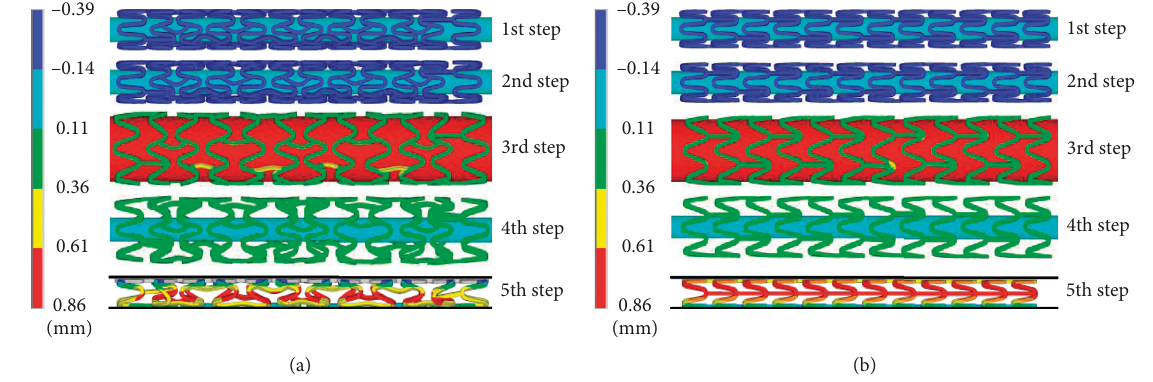
Figure 10: Deformations of the (a) OCS and (b) BVS at different steps during FEA. Table 2: Outer diameters and lengths of the OCS and BVS at different steps during FEA. Stent type